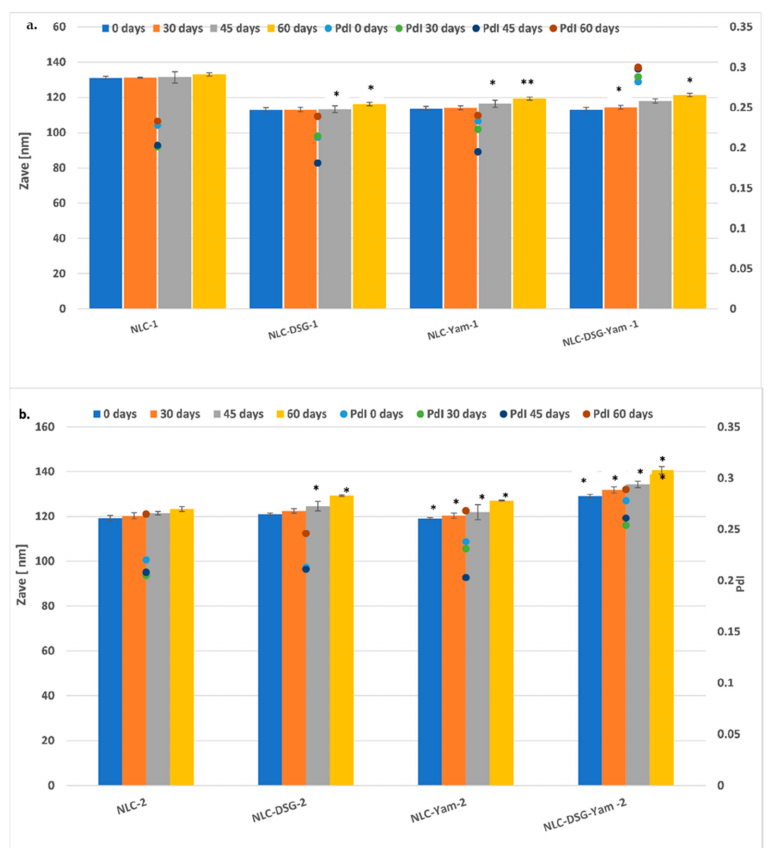
Figure 2. Variation of mean diameters (Zave) and polydispersity index (PdI) for the nanocarriers prepared with EPO ( a ) and for those prepared with SOY ( b ). * p < 0.05; ** p < 0.005; NS p > 0.05 (NS). Data are expressed as mean ± SD, n = 3 NLC-DSG1/2, 0 days vs. other